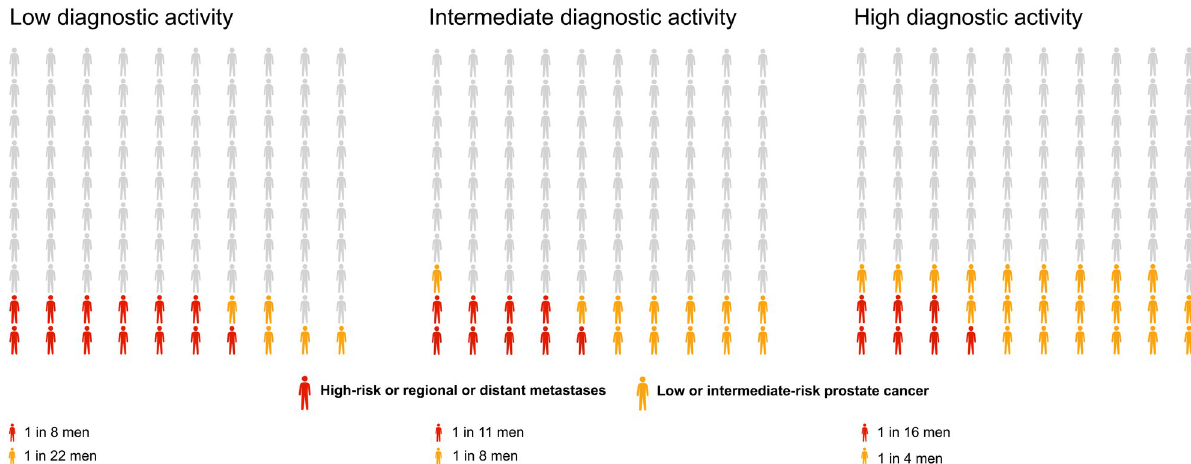
Fig 3. Lifetime risk of low to intermediate-risk prostate cancer diagnosis (in blue), and high risk or metastatic prostate cancer (in red) under three levels of diagnostic activity: Low as in Sweden 1992; Intermediate as in Sweden 2016; High as in Stockholm 2014; when the Stockholm-3 study invited men to measure their PSA [15].